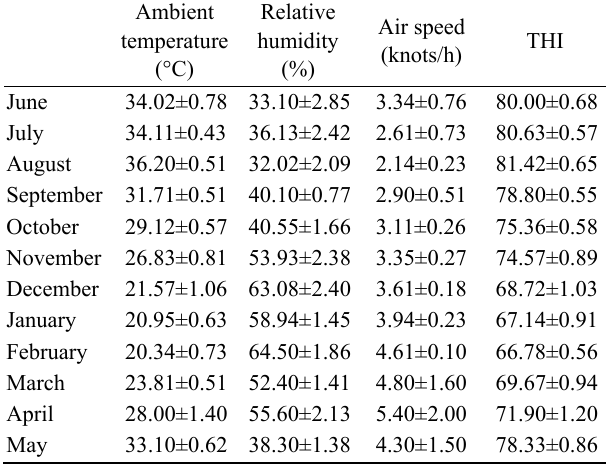
Table 2 . Monthly averages of maximum ambient